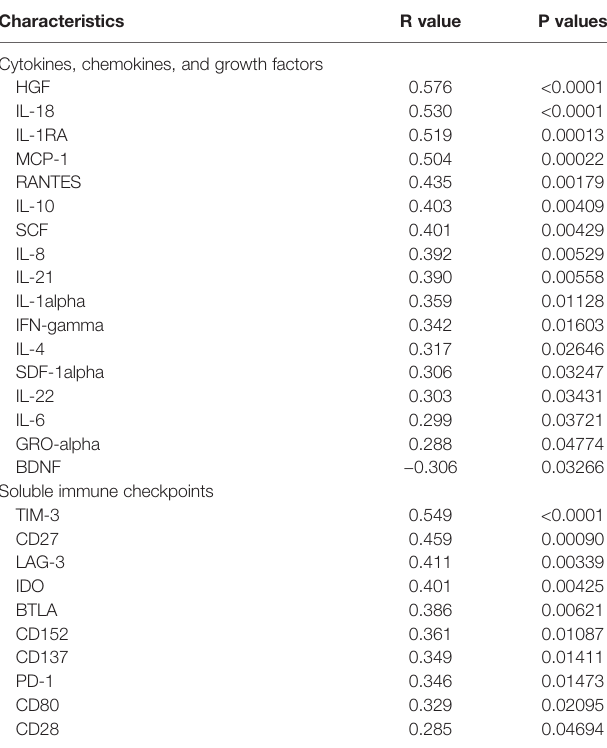
TABLE 2 | Correlations between CD38 hi HLA-DR + percentage and soluble immune checkpoints, cytokines, chemokines, and growth factors in patients infected with